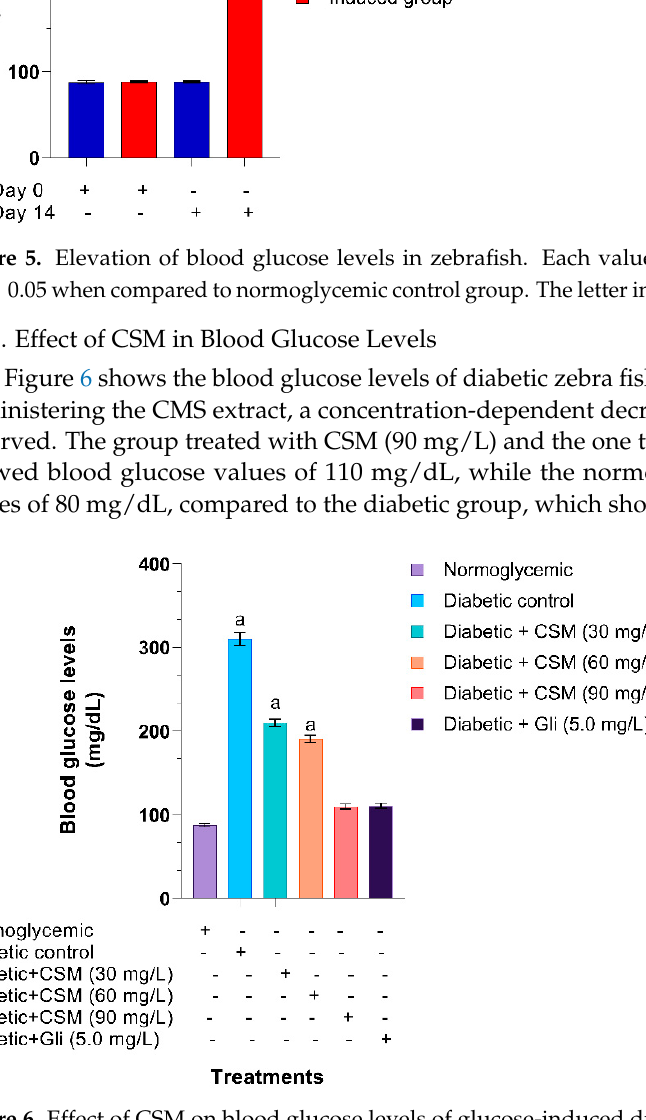
Figure 7. Effect of CSM on glucose-induced zebrafish triglycerides and cholesterol levels at the end of the experimental period (14 days). Data are expressed as the mean ±SE. a p ≤ 0.05. when compared to normoglycemic control group. The letters indicate significant differences between the different treatments. CSM; methanol extract from the seed of S. purpurea , Gli; glibenclamide.